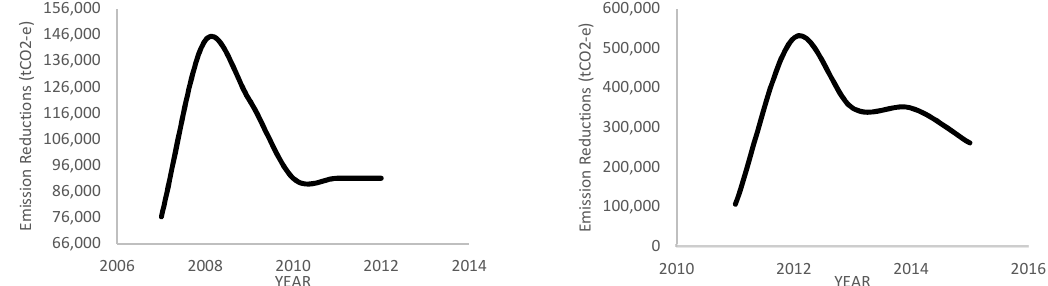
Figure 3. Examples of emission reductions generated by Clean Development Mechanism (CDM)-registered wind energy projects. Top: Data collected from the Essaouira wind power project in Morocco. Bottom: Data collected from the Hebei Guyuan County Dongxinying 199.5 MW wind power project in China. In the case of China, a dramatic decline in energy output occurred beginning in 2008. In Morocco the decline started in 2012. In both cases, none of the projects’ output levels had yet recovered, five years after the onset of the decline (Emission reductions data were collected from the project documents, and monitoring reports are available at the CDM project database).